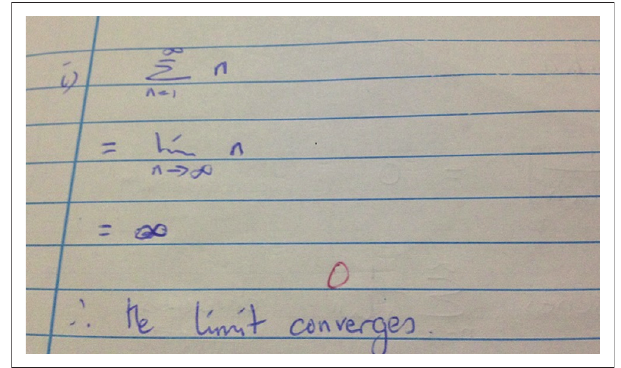
FIG URE 3: Written response of ST17 to task 1b (i). An example of a response where the student operated at N level.